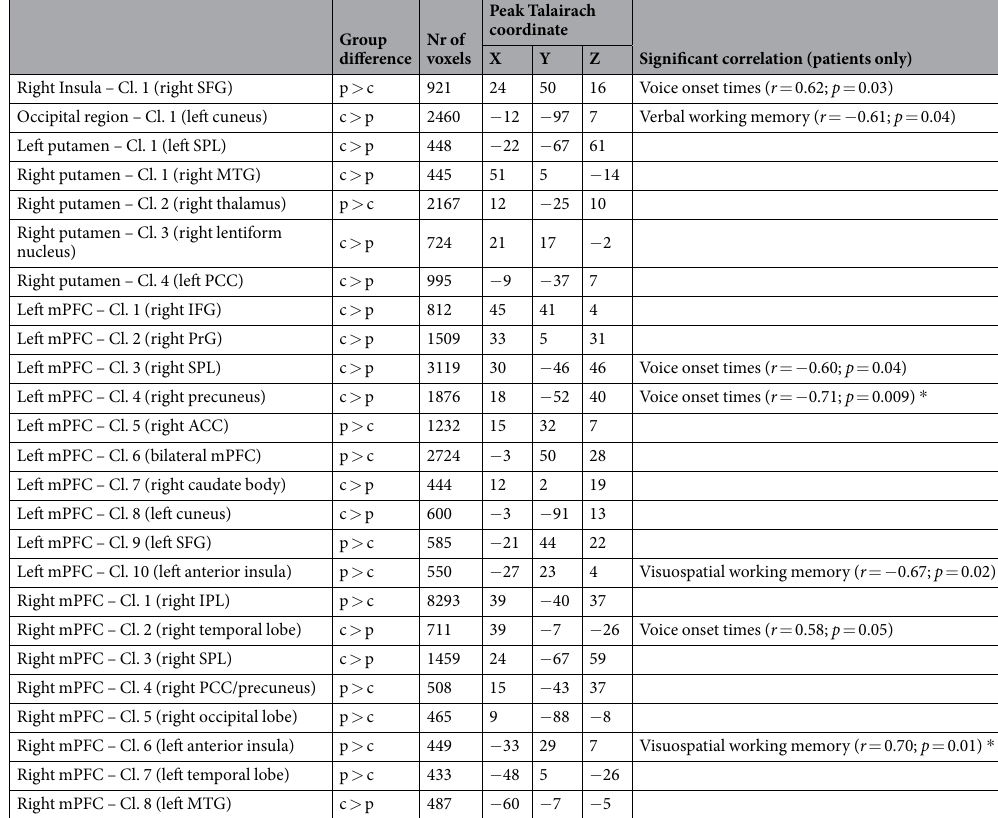
Left pre-supplementary motor area. Connectivity maps showed that the left pre-SMA seed was func- tionally connected with bilateral (pre-)SMA and premotor cortices and the left PrG in the control group (Fig. 4A). A similar network was seen in patients. However, several additional regions were correlated, including the right PrG, the left mPFC and left SFG (Fig. 4A). Statistical comparison failed to show any significant group differences. Occipital region. PrG in controls (Fig. 4B). In the control group bilateral PrG, right pre-SMA and cerebellum were also correlated. In patients, less extensive correlation was seen with the occipital region surrounding the seed, especially bilateral middle occipital gyri and cuneus, as well as with right precuneus, cerebellum and motor areas (Fig. 4B). Statistical tests confirmed decreased functional connectivity in patients with regard to left cuneus (Fig. 4B, Table 1). Correlations with neurocognitive tests. A significant correlation between the patients’ beta values (repre- senting the functional connectivity with the seed region) and results of neurocognitive tests was found for eight clusters (Table 1, Fig. 5A). Several seed-cluster connectivity measures correlated with voice onset times (VOTs) from a language production task. Functional connectivity between the right insula and the right SFG (cluster 1) was positively correlated with VOTs ( r = 0.62, p = 0.03). This cluster showed increased functional connectivity in the patient group as compared to controls, which altogether suggests that increased connectivity correlates with lower performance (slower VOTs) in patients. Functional connectivity between the left mPFC and both right SPL and right precuneus were negatively correlated with the VOTs ( r = − 0.60, p = 0.04; r = − 0.71, p = 0.009, surviving Bonferroni correction). These clusters showed decreased functional connectivity in patients as compared to controls, which altogether suggests that decreased connectivity correlates with lower performance (slower VOTs) on language production in the patient group. Lastly, functional connectivity between the right mPFC and right temporal lobe was positively correlated with VOTs ( r = 0.58, p = 0.05). This cluster showed increased functional connectivity in the patient group as compared to controls, which altogether suggests that increased connectivity correlates with lower language performance (slower VOTs) in patients.